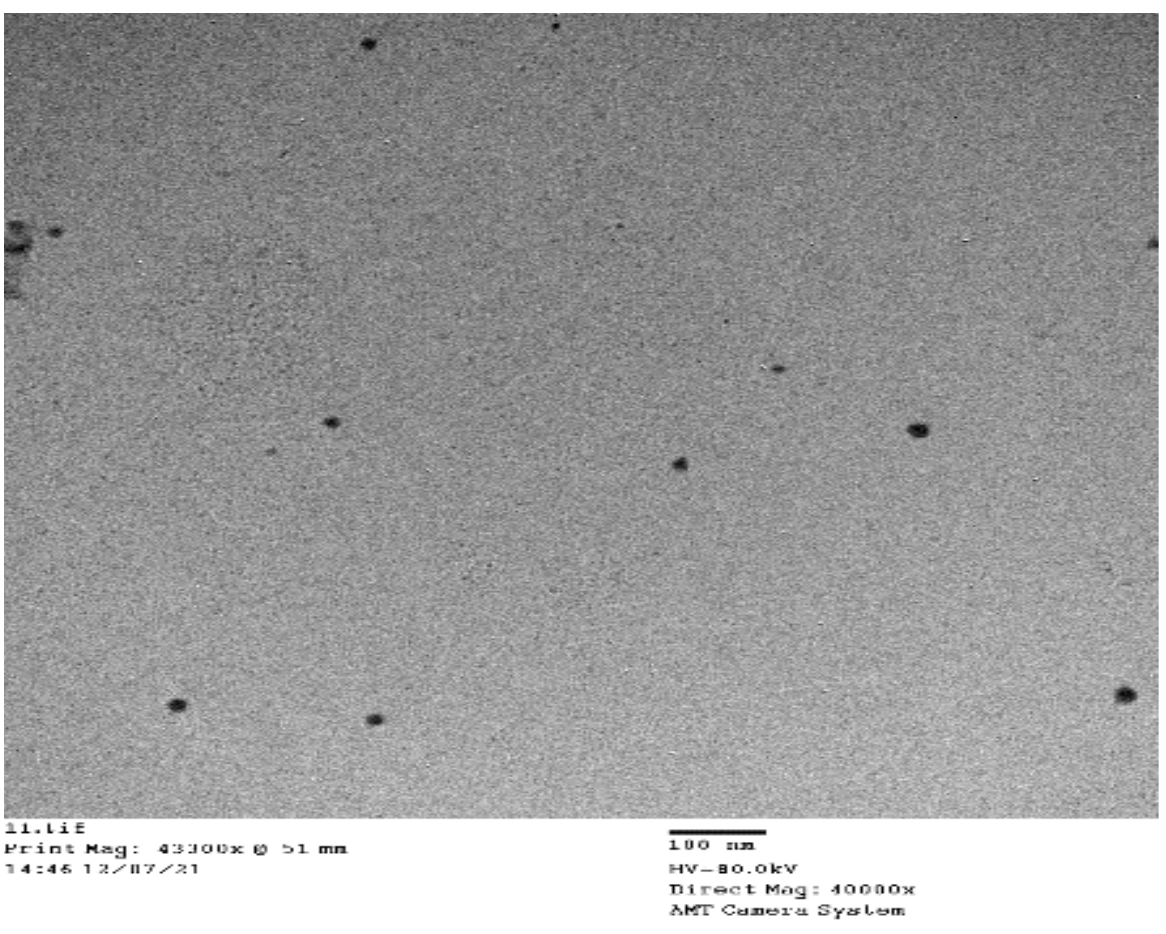
Figure 1. The characterization of nano curcumin (NC) by the Electron Microscope.